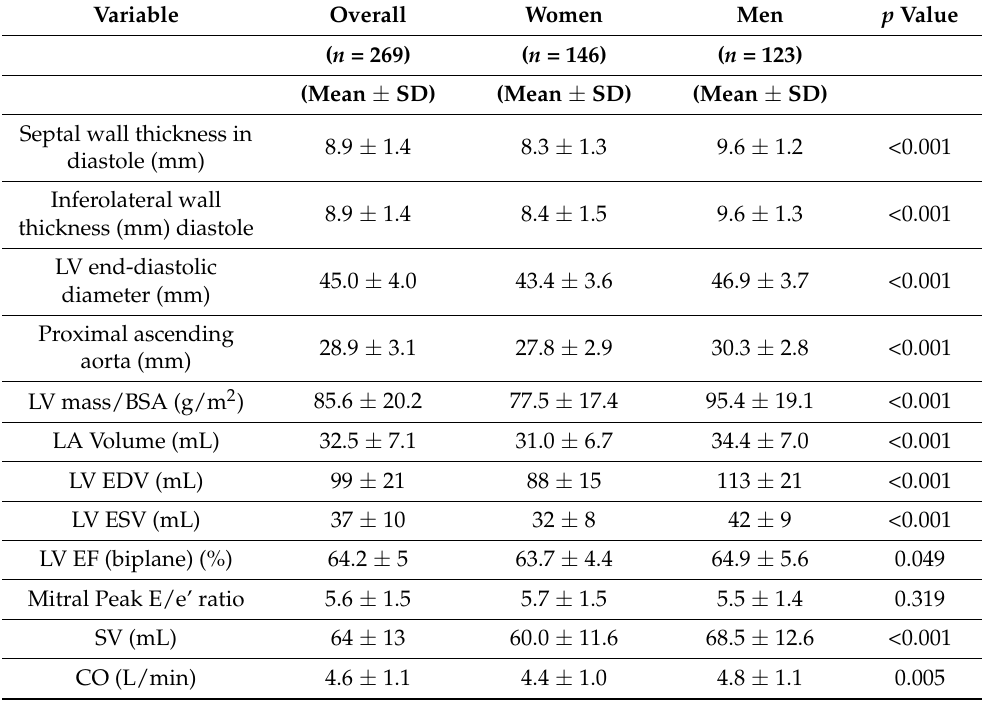
Table 2. Left heart structure and function in study population.